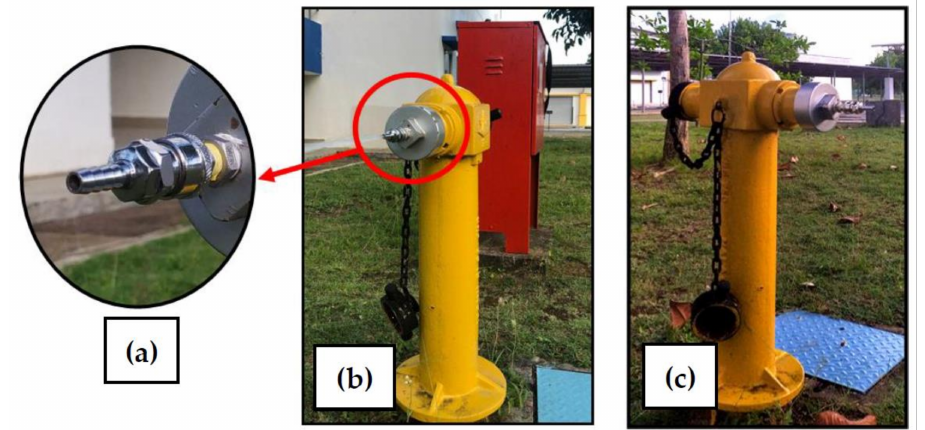
Figure 7. Experimental facility: ( a ) 5 mm diameter gas connector fitted on customised fire hydrant cap; ( b ) Leak induced on Fire Hydrant 2 (Figure 6); ( c ) Leak Induced on Fire Hydrant 3 (Figure